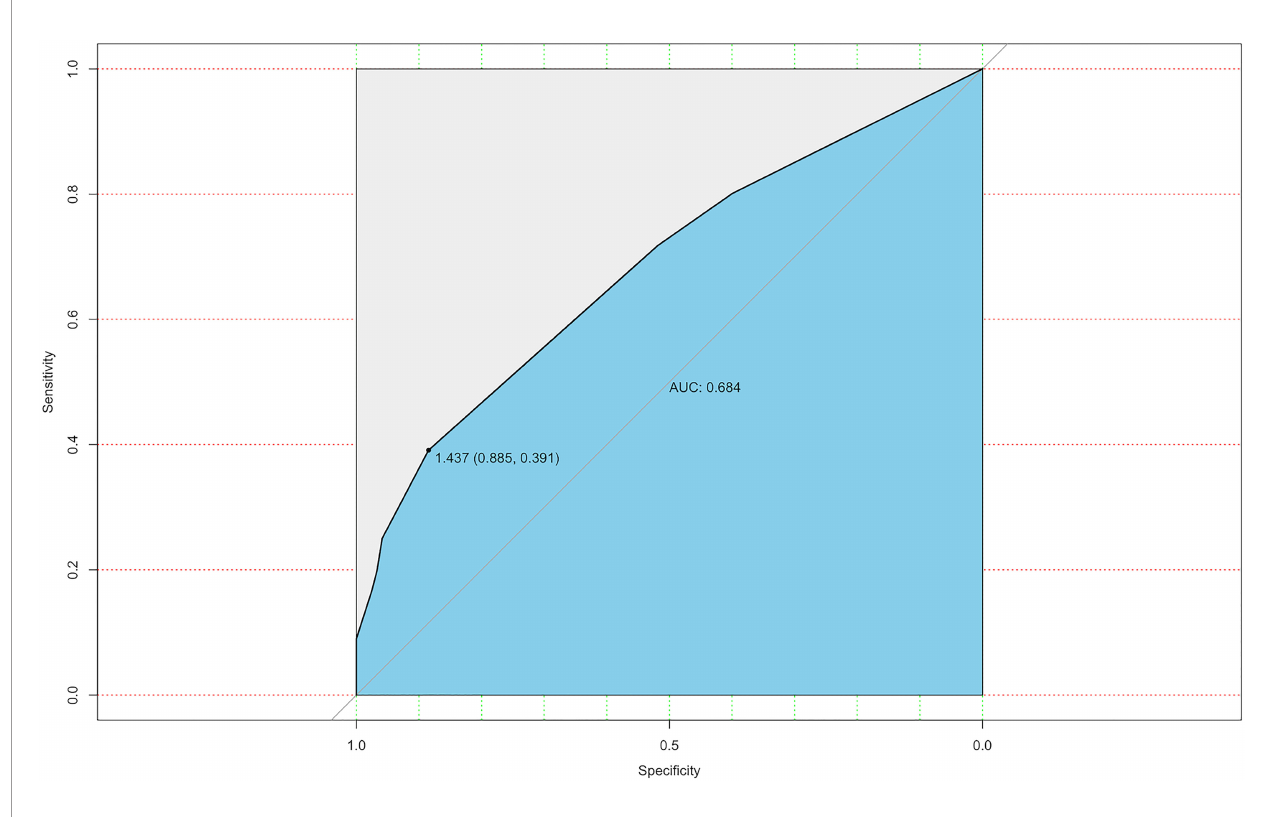
FIGURE 3 | ROC curve for predicting model.